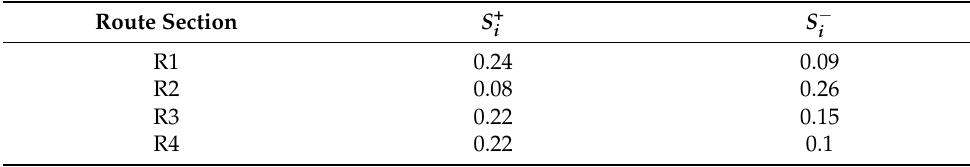
Table 7. Distance to positive and negative ideal solution planes.